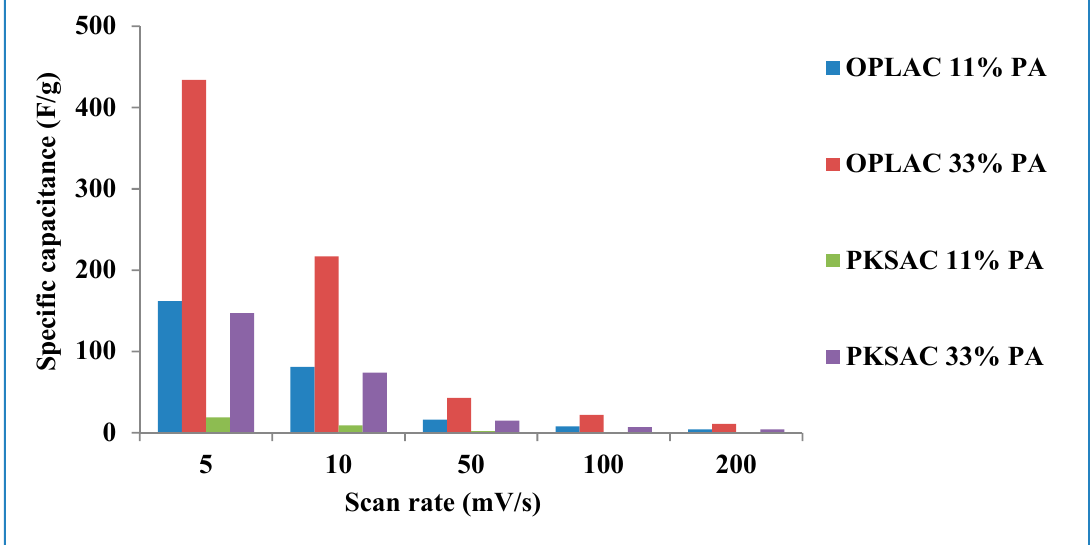
Figure 11. Cyclic voltammogram (CV) and galvanostatic charge and discharge (GCD) curves of the as-fabricated activated carbon obtained from palm kernel shell-derived precursors. ( a ) and ( b ) represents the CV curves of the PKSAC-11% PA and PKSAC-33% PA, respectively, measured at different scan rates; While ( c ) and ( d ) represents the GCD profiles of PKSAC-11% PA and PKSAC-33% PA, respectively, measured at different current densities.